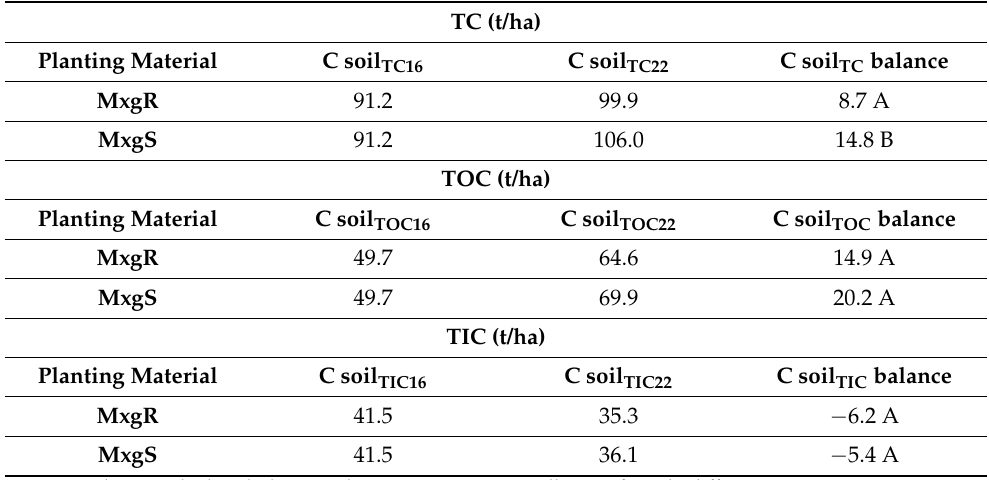
Table 3. Carbon balance within the soil pool in relation to the total, organic, and inorganic carbon